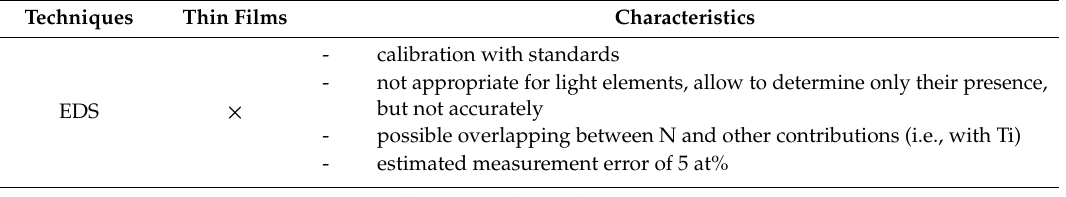
Table 2. Characteristics of the physical